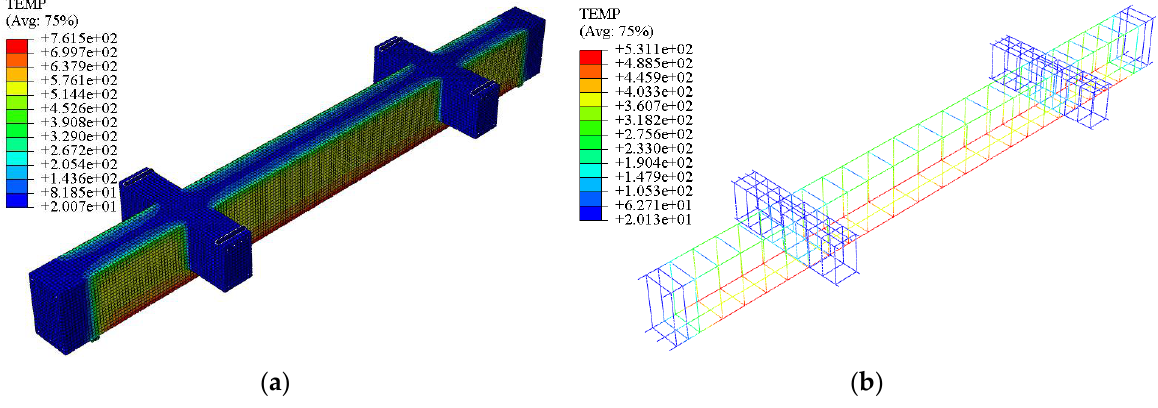
Figure 12. The temperature field distribution of beam JJLH1: ( a ) concrete and ( b ) steel.